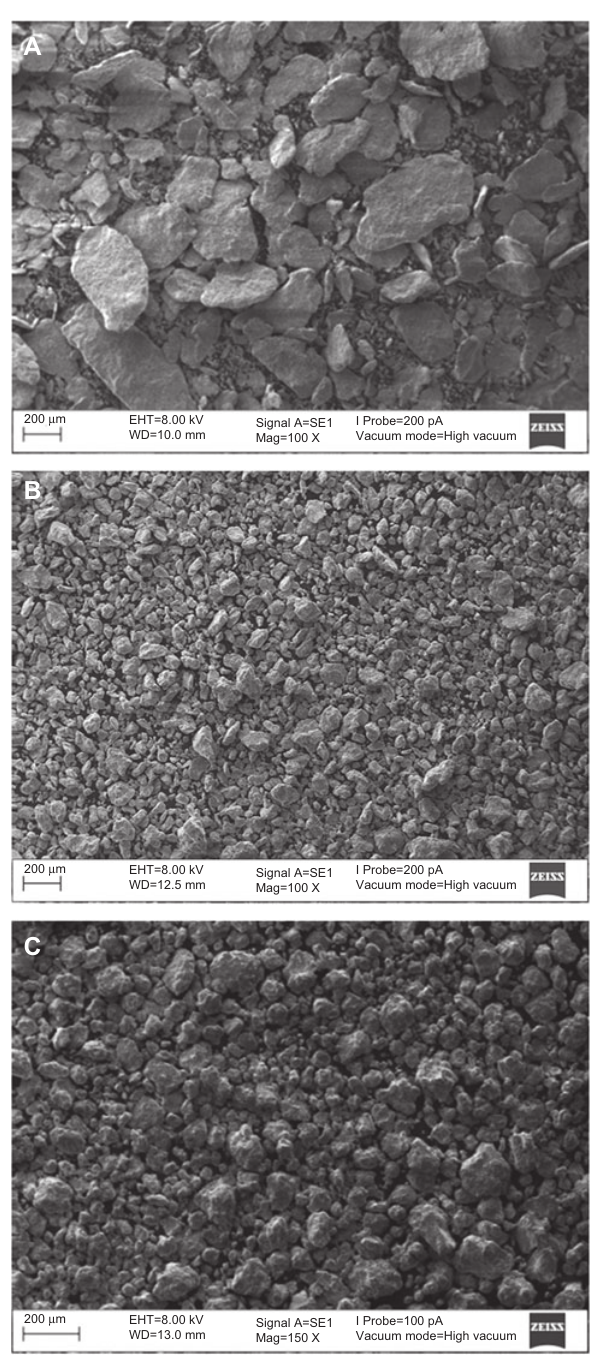
Figure 4 Morphology of Al-5 vol. % Al function of milling time: (A) 0.5 h, (B) 2 h, (C) 7 h.